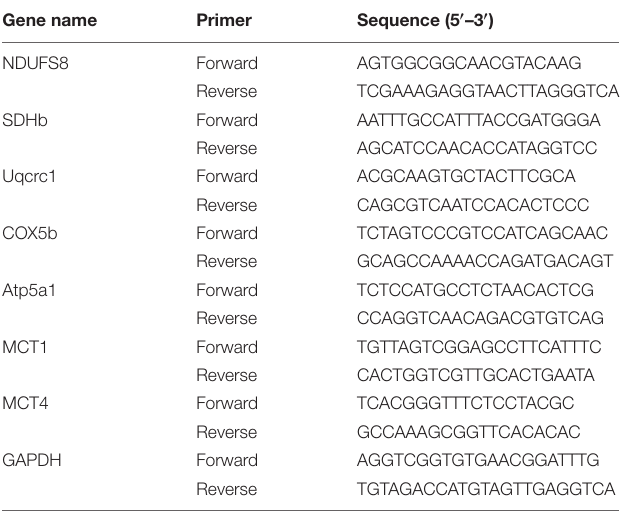
TABLE 2 | Primer sequences used for RT-PCR analysis of mice cDNA.